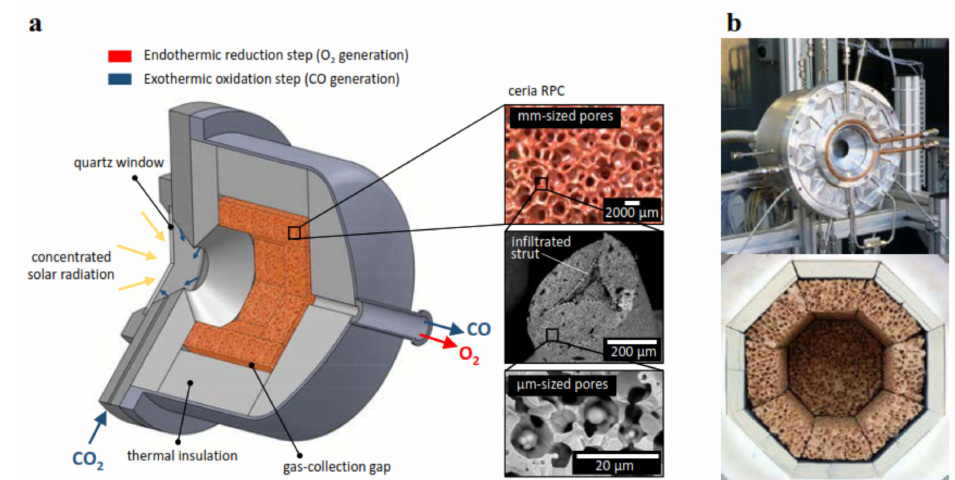
Figure 11. ( a ) Schematic representation of the solar reactor for carbon dioxide splitting, comprising a windowed cavity-receiver containing a ceria RPC with dual pore sizes (mm- and µ m-sized pores); ( b ) images of the front face of the solar reactor with the windowed aperture and its interior containing the octagonal ceria RPC structure insulated with a line of alumina